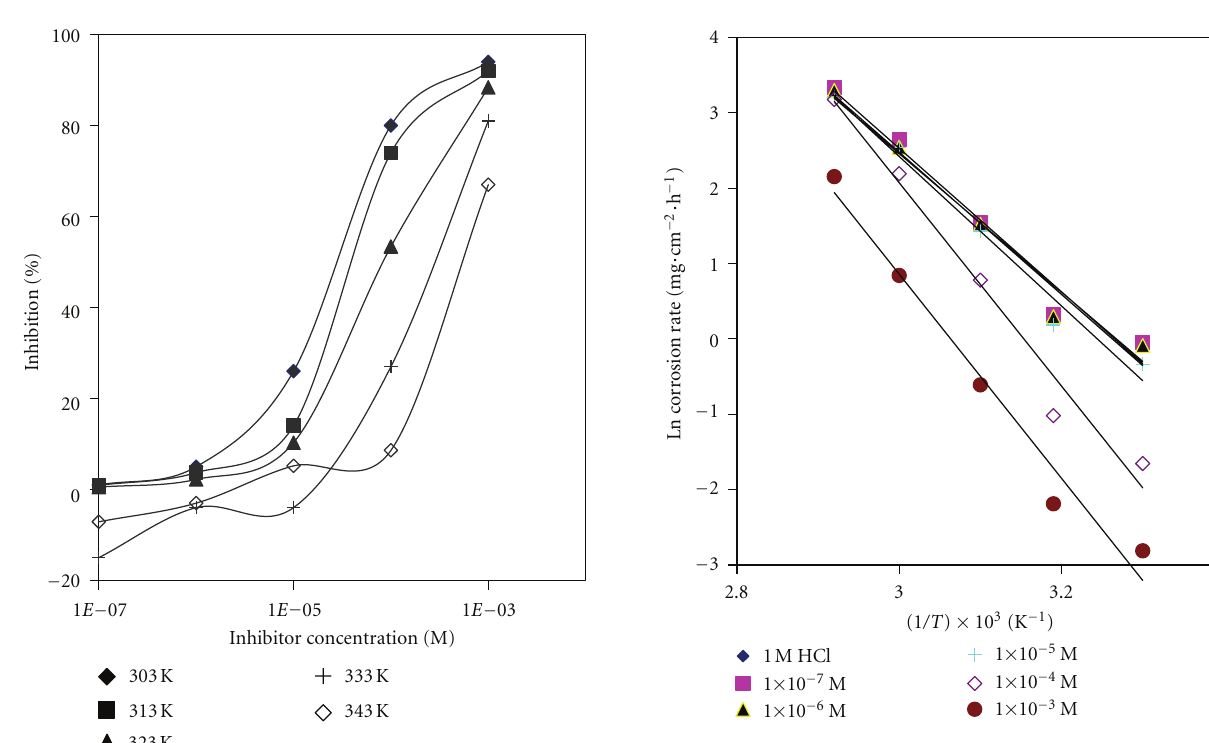
Figure 3: E ff ect of concentration of trans-4-hydroxy-4 (cid:2) -stilbazole on the percent inhibition of mild steel in 1M HCl at various temperatures.